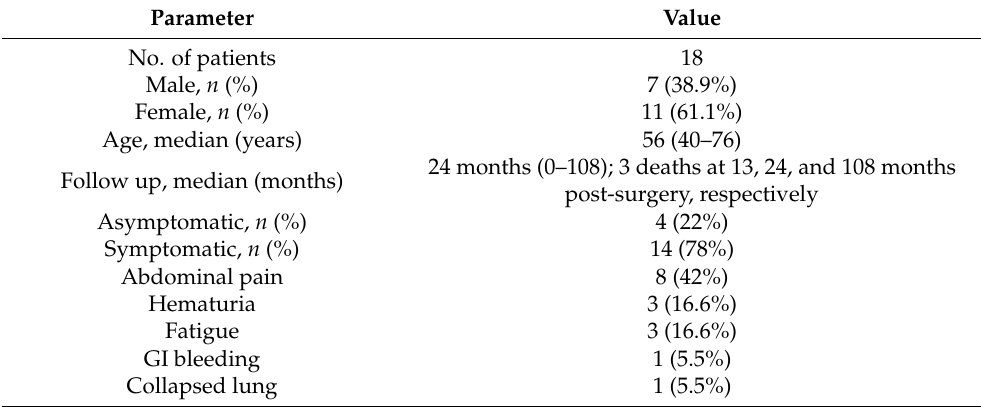
Table 1. Demographic